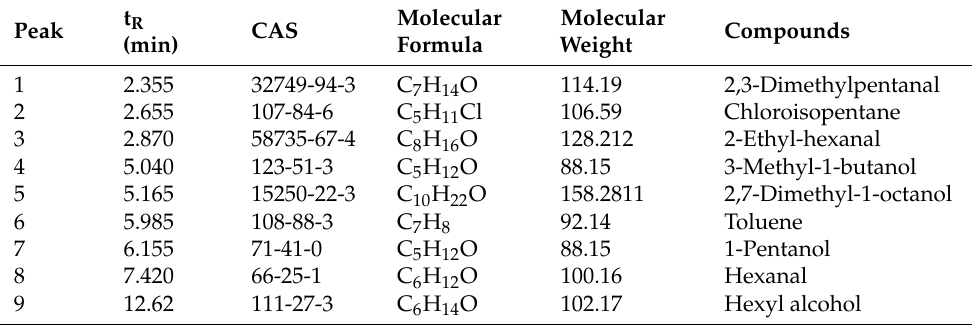
Table 1. Volatile constituents of NC89 tobacco seed oil.